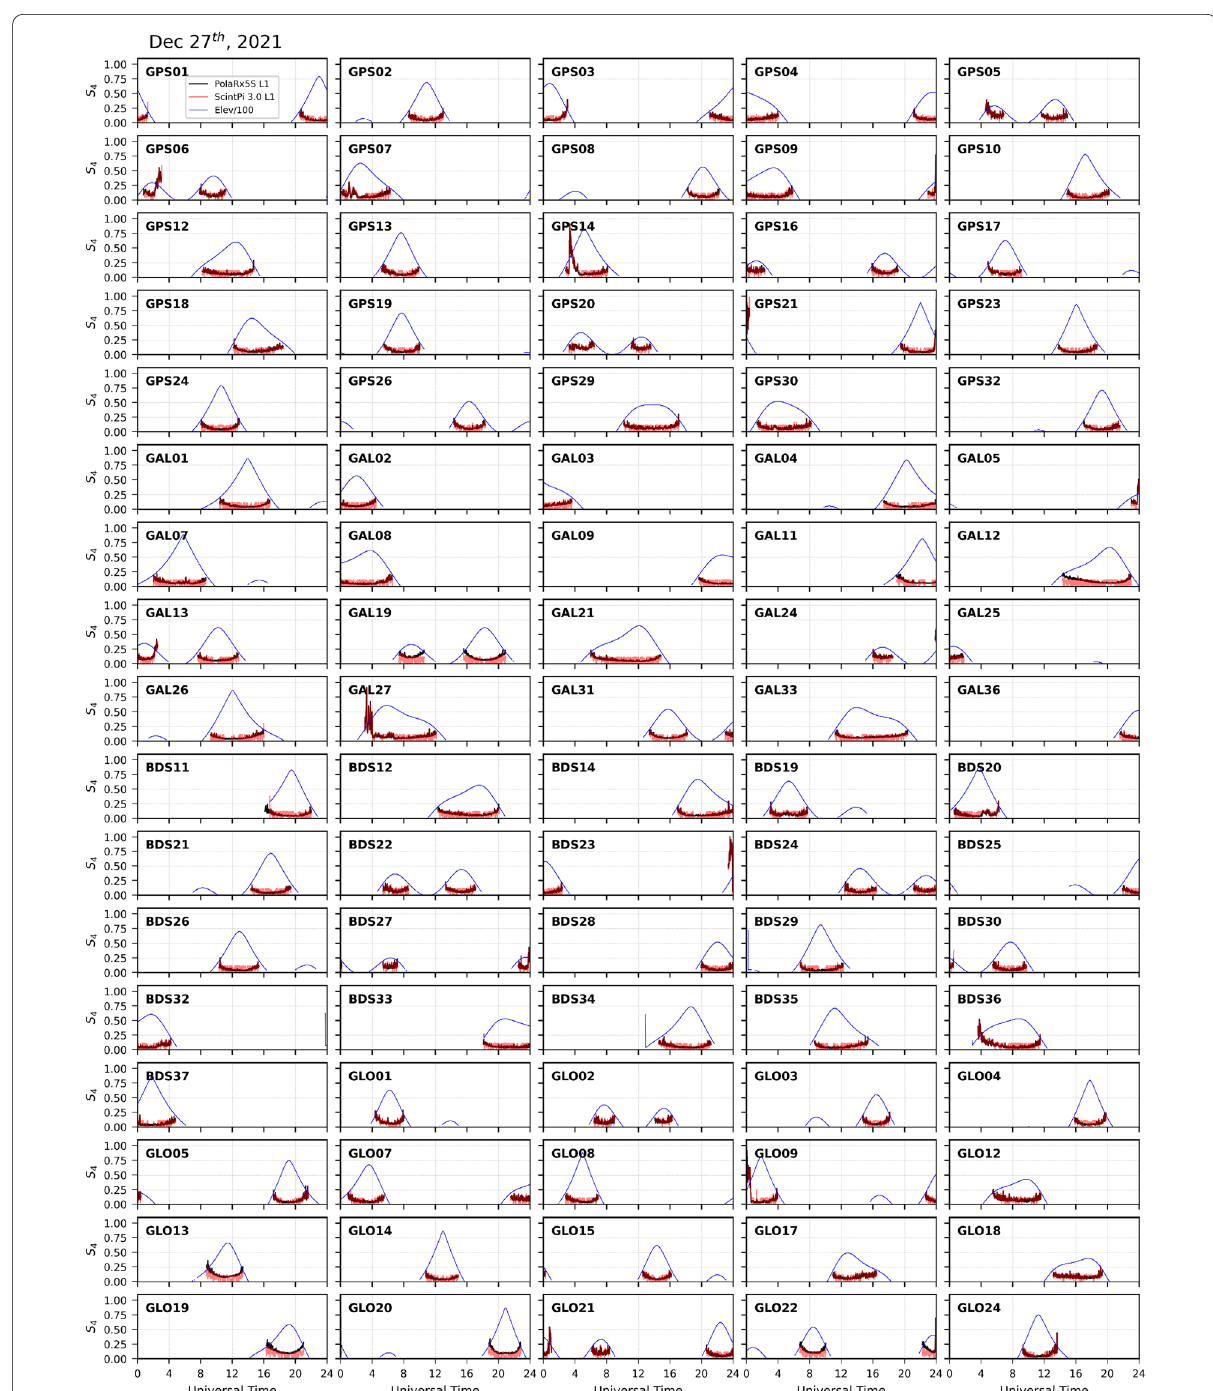
Fig. 3 Summary of L1 (~ 1.6 GHz) S 4 measurements made by ScintPi 3.0 (red curves) and collocated Septentrio PolaRx5S (black curves) on December 27, 2021. These monitors were collocated in Presidente Prudente (PPR), Brazil. The blue curves represent satellite elevation angles. The constellation and satellite identifier number are indicated in each